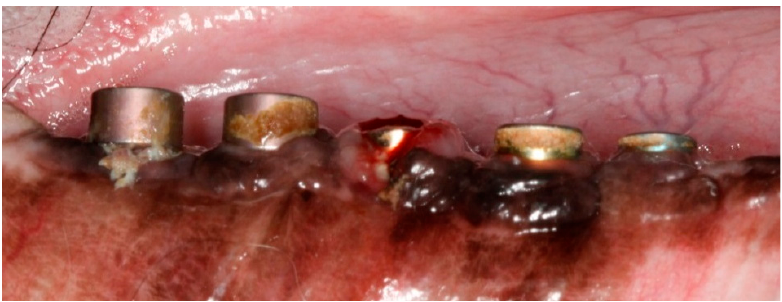
Figure 1. Post-operative image at 9-month post-implantation. Note the ligatures placed in implants 1, 3 and 5, and the subsequent local inflammation.